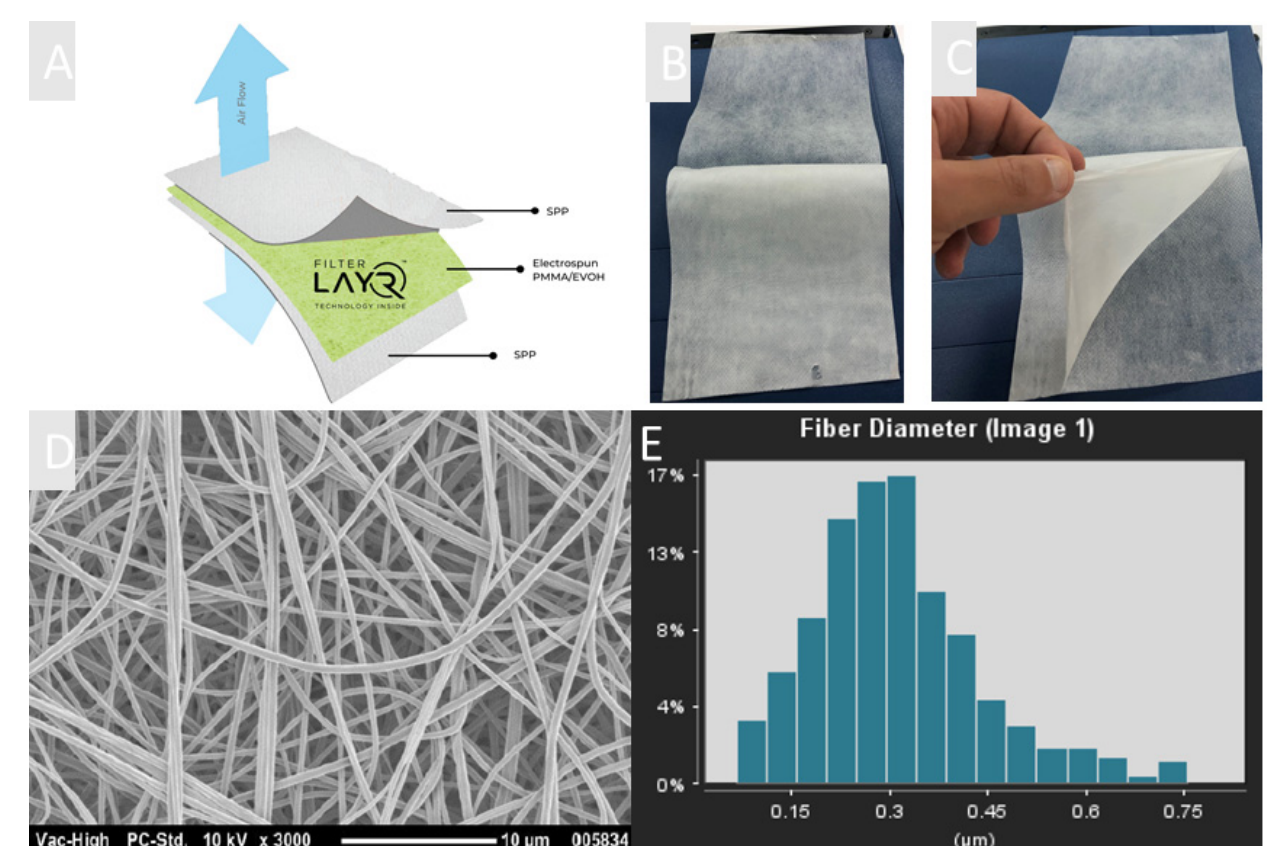
Figure 3. ( A ) Diagram of FilterLayr TM structure: spunbonded polypropylene/PMMA–EVOH electrospun nanofibre/spunbonded polypropylene (SPP/PMMA–EVOH/SPP). ( B ) Macroscopic image of SPP/PMMA–EVOH/SPP structure. ( C ) Nanofibre layer in FilterLayr TM . ( D ) SEM micrograph of nanofibre layer made from a blend of PMMA and EVOH. ( E ) Average fibre distribution of PMMA–EVOH electrospun fibres using Fibraquant image analysis software.